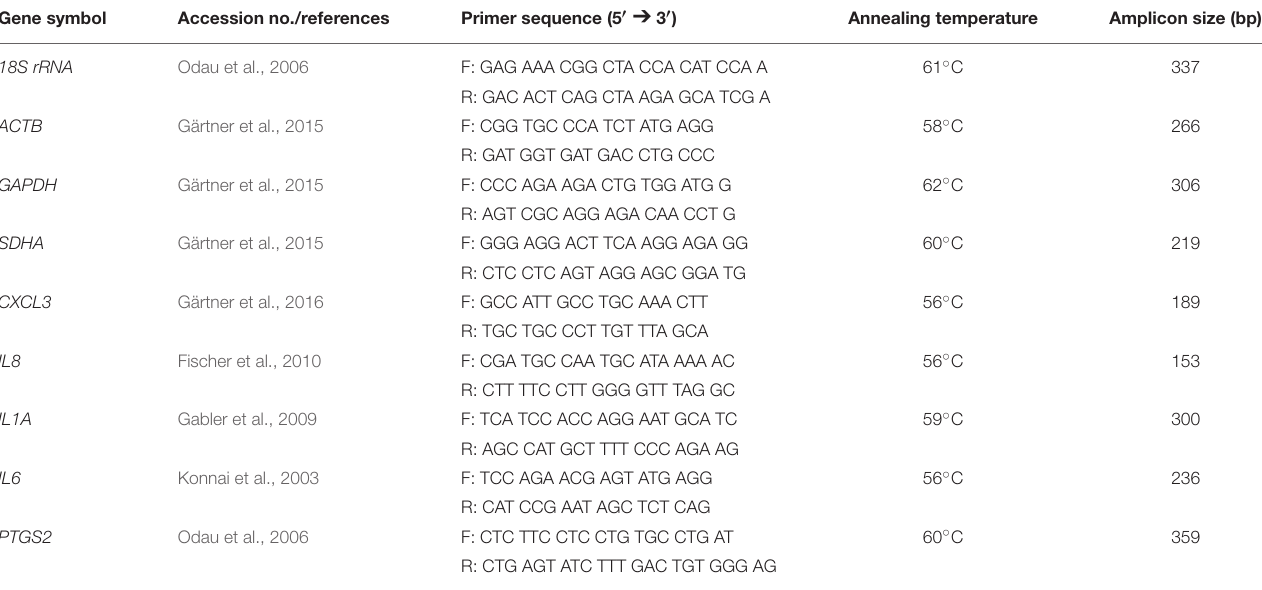
TABLE 2 | Selected bovine gene transcripts, primer sequences, and annealing temperatures used for quantitative PCR with expected amplicon size. Gene